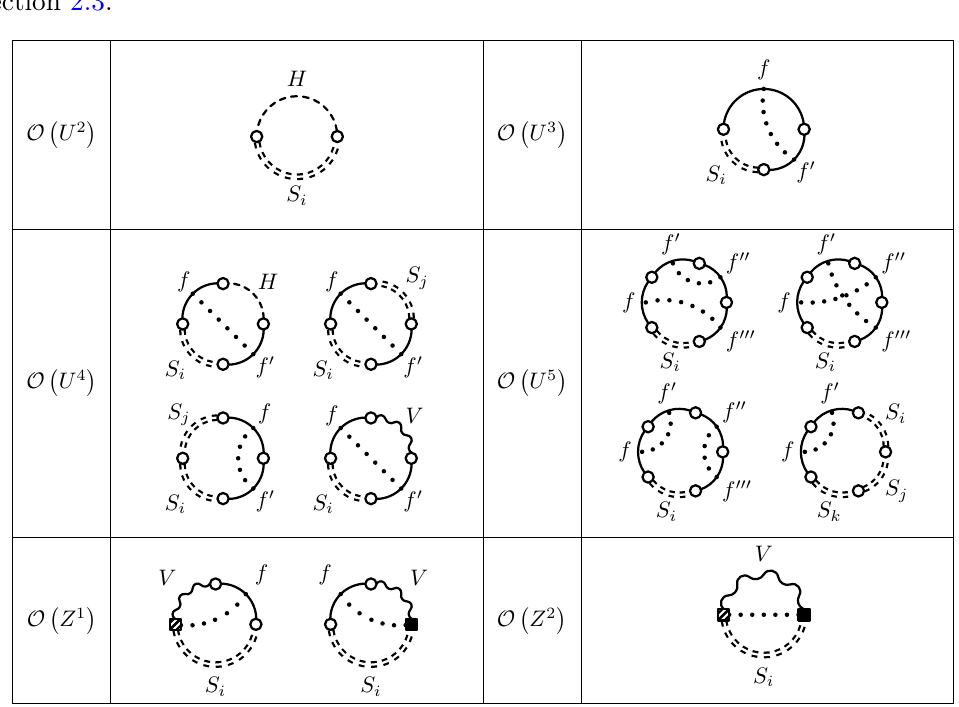
˜ = S S 2 , f = ‘, q, u, e, d and V = B, W, G . In total we count 13 i 1 ,